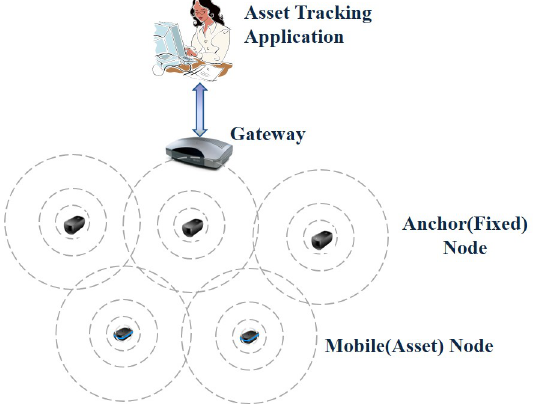
Figure 2. System architecture